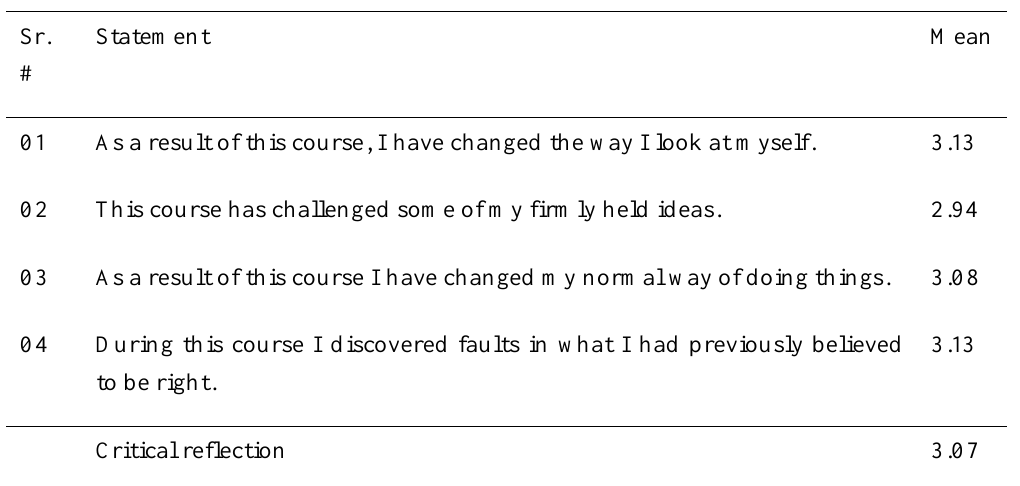
Students’ Thinking Practices to Gain Critical Reflection